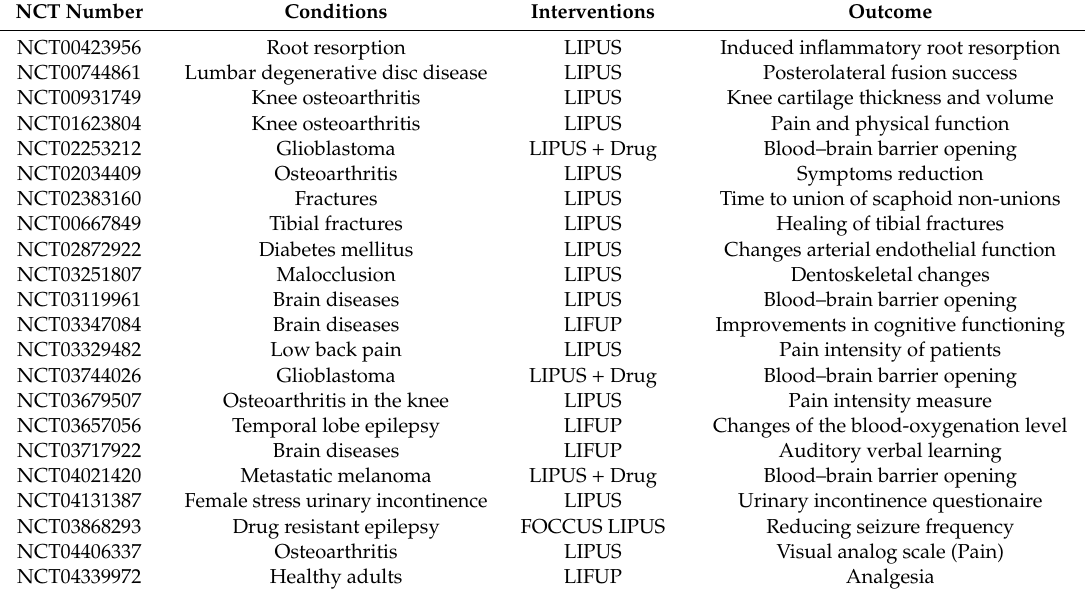
Table 6. Clinical studies carried out for tissue healing with di ff erent LIPUS therapies. (LIPUS